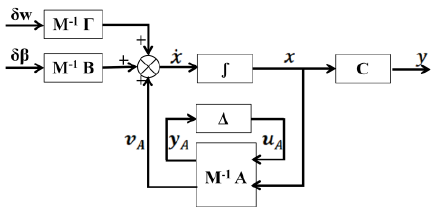
Figure 2. Block diagram of a nominal wind turbine model Figure 3. System block diagram with uncertain parameters represented in uncertain matri x Δ